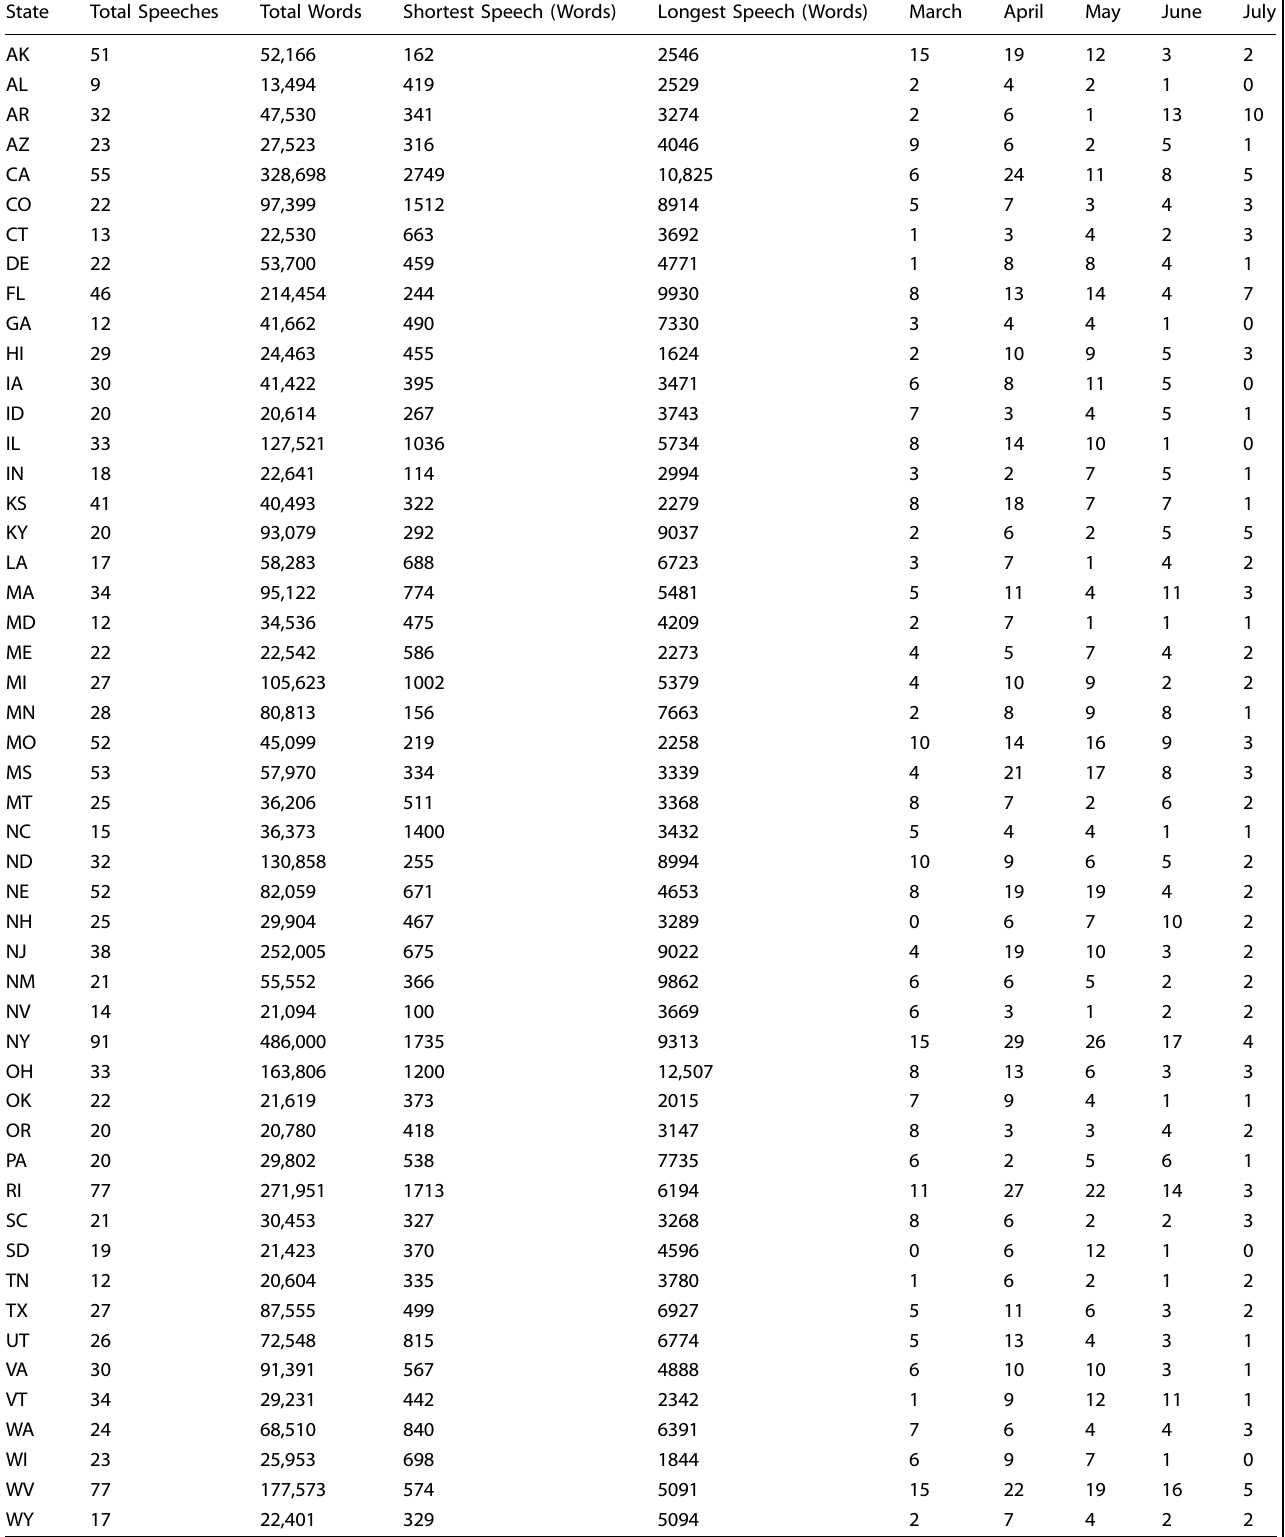
States are identi fi ed by standard two-letter